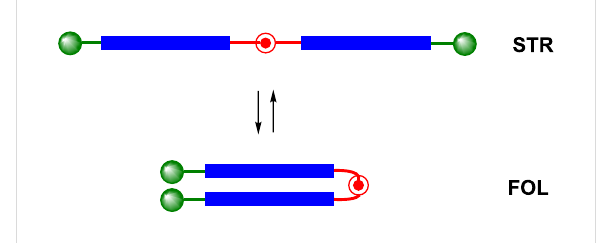
Figure 2: Fundamental structure of articulated rods (blue = legs, red = joint, green = terminal functionalities).